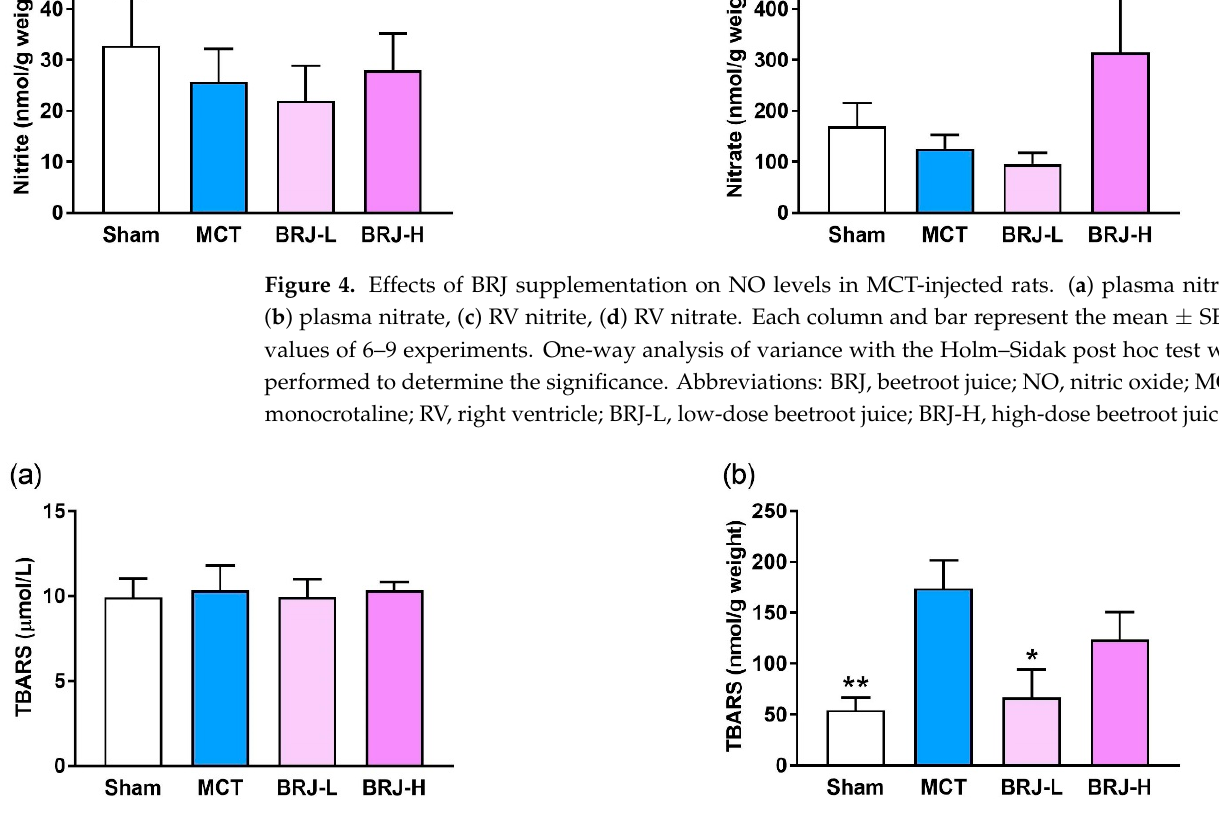
Figure 5. Effects of BRJ supplementation on oxidative stress in MCT-injected rats. ( a ) plasma TBARS, ( b ) RV TBARS. Each column and bar represent the mean ± SEM values of 6–9 experiments. One-way analysis of variance with the Holm–Sidak post hoc test was performed to determine the significance; * p < 0.05 and ** p < 0.01, compared to the MCT group. Abbreviations: BRJ, beetroot juice; MCT, monocrotaline; RV, right ventricle; TBARS, thiobarbituric acid reactive substances; BRJ-L, low-dose beetroot juice; BRJ-H, high-dose beetroot juice.